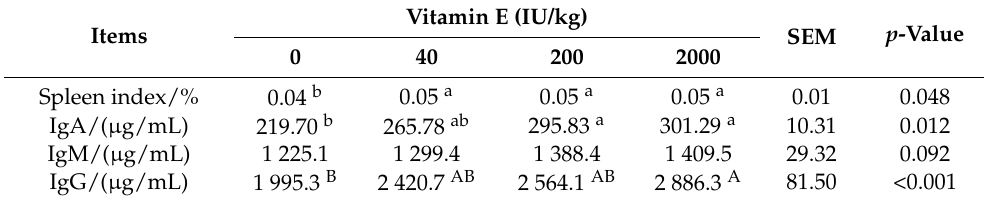
Table 8. Effects of dietary vitamin E supplementation on immune status in breeding geese 1 . Items